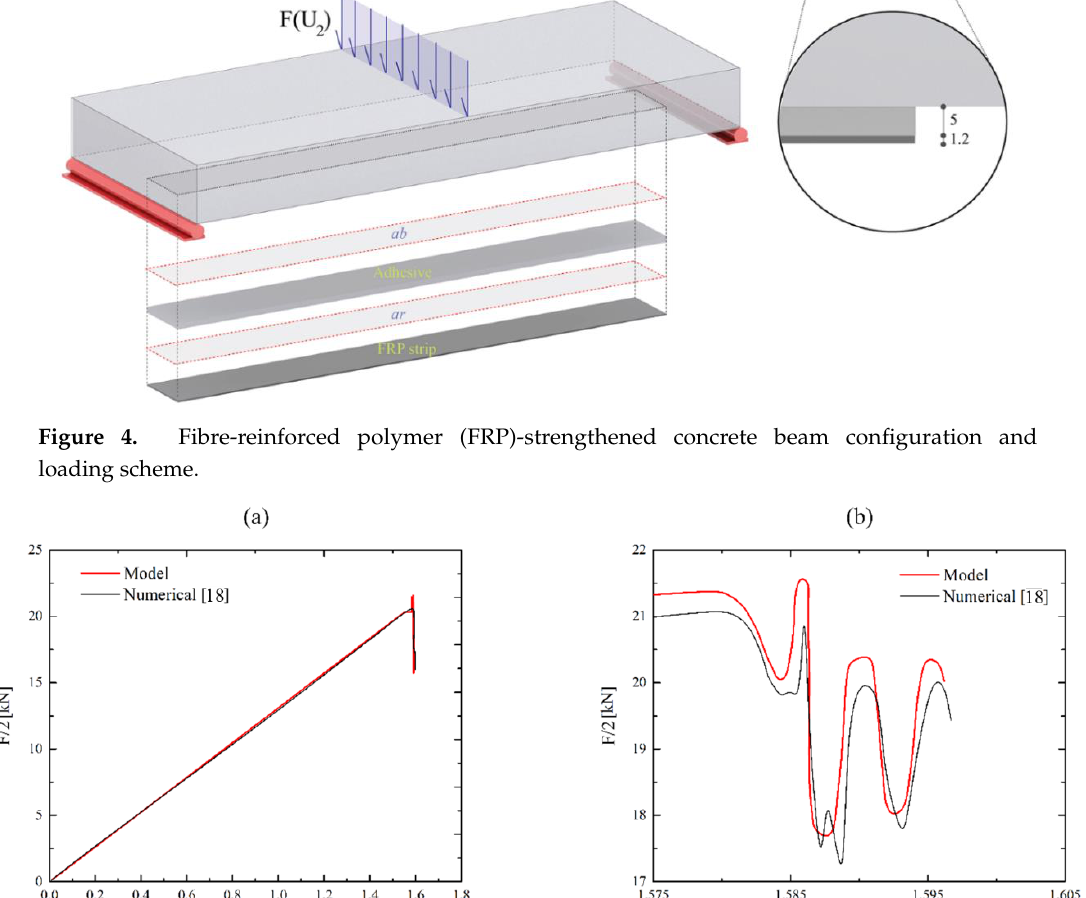
Figure 4. Fibre-reinforced polymer (FRP)-strengthened concrete beam configuration and loading scheme.